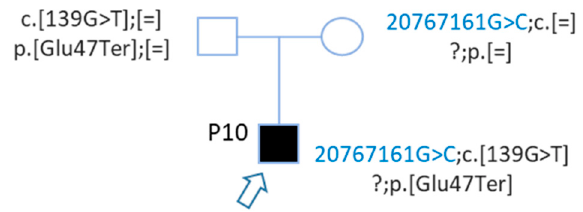
Figure 7. Segregation of GJB2 variants of patient P10. Hearing parents were carrying each a GJB2 variant, the nonsense and the upstream variant. Patient P10 carried these 2 mutations in trans.